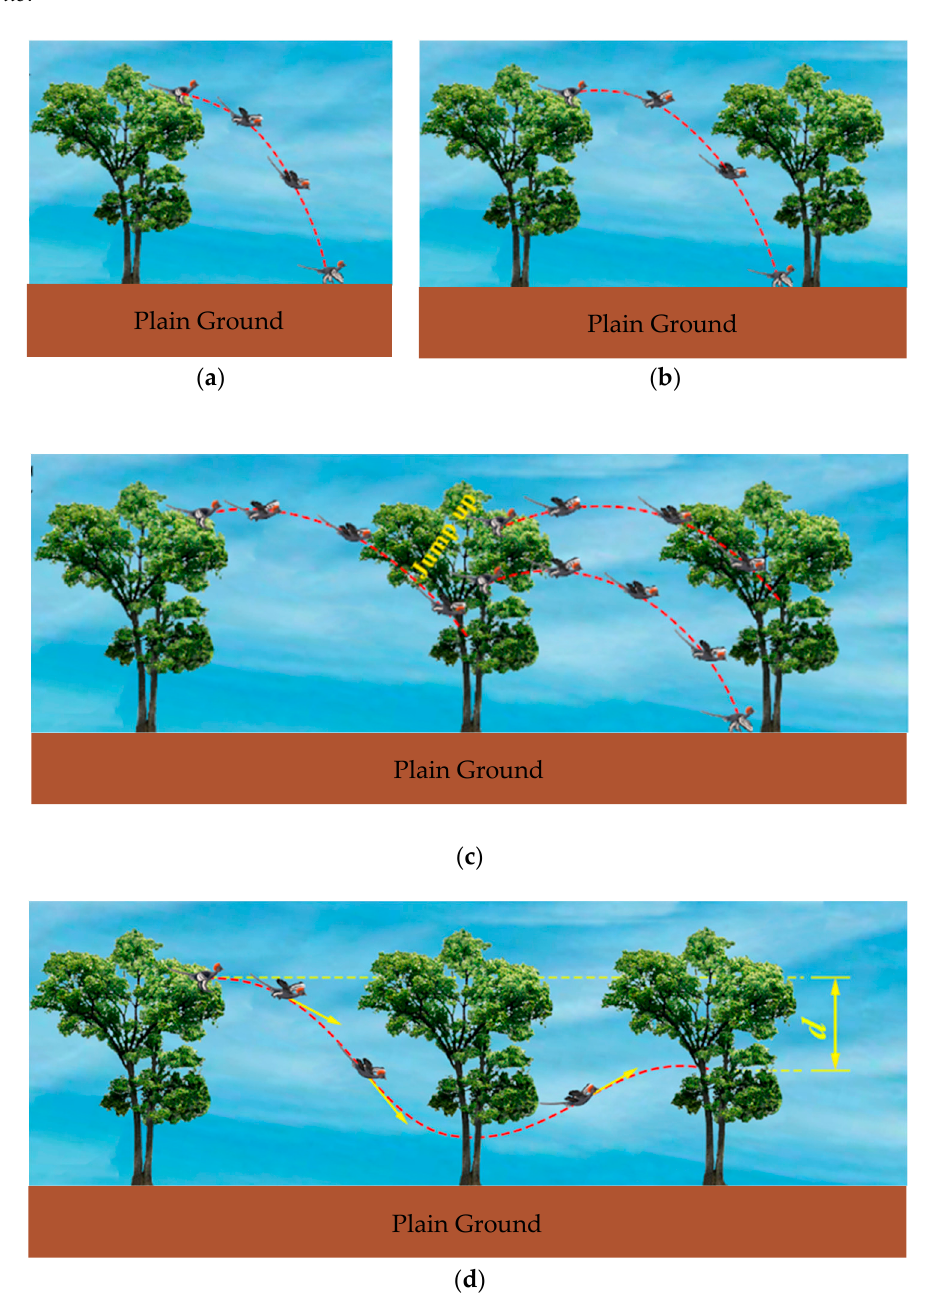
Figure 8. Process of arboreal gliding: ( a ) A theropod parachuting from the branch of a tree to the ground; ( b ) Trying to glide from one tree to another; ( c ) The theropod could glide from the higher position of one tree to the lower position of another; ( d ) The theropod could change its trajectory by adjusting its orientation during gliding so that the resultant force could lift it to a position.